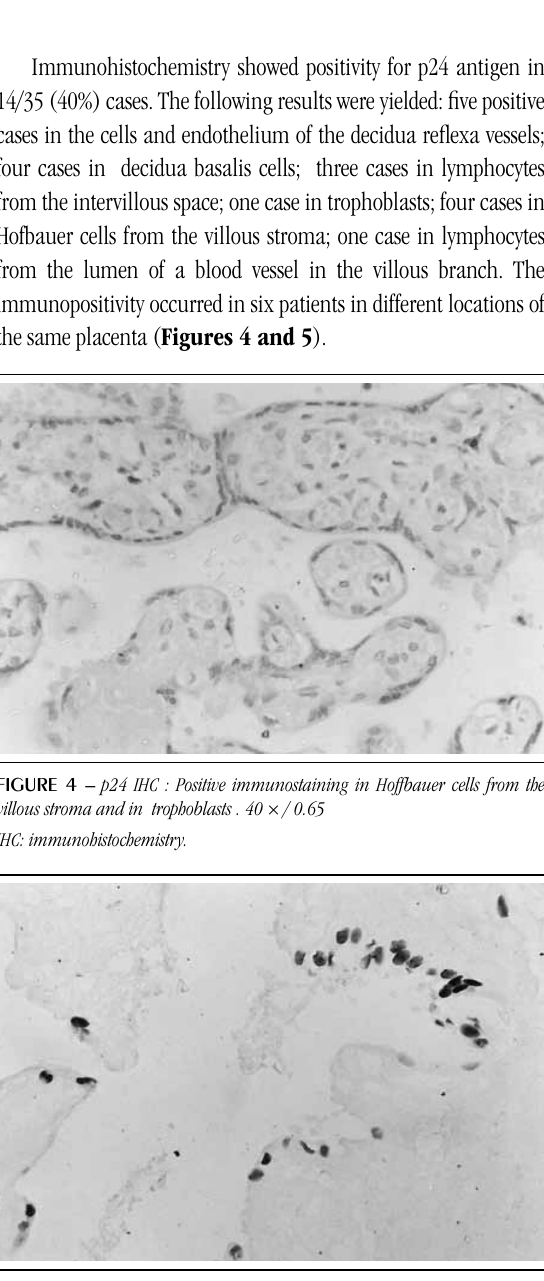
figurE 5 – p24 IHC: positive immunostaining in the decidua and trophoblasts. 40 × / 0.65 IHC: